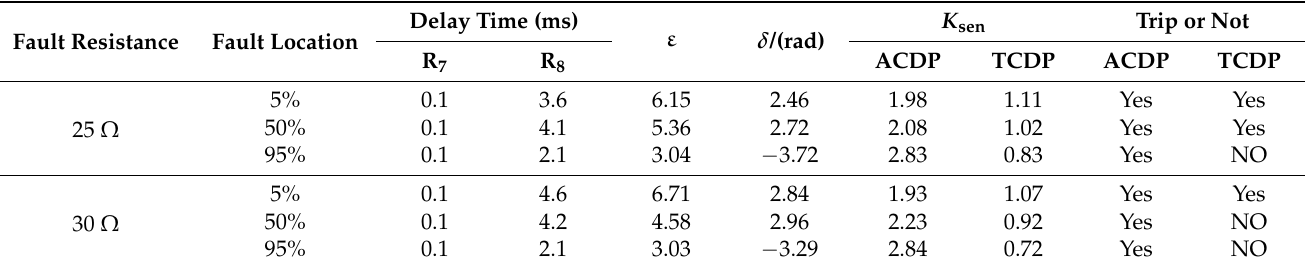
Table 7. Simulation results of time synchronization error test. Fault Resistance